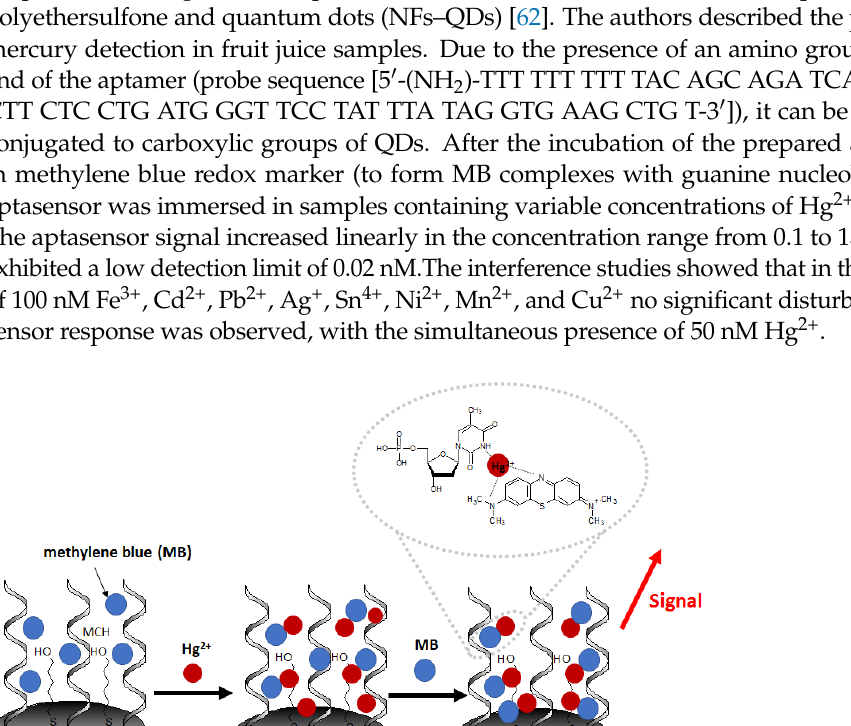
Figure 9. Schematic illustration of signal- on switch aptasensor using “Au nanoflowers” -decorated electrode. Adapted with permission from Zhang et al. [63] (Copyright © (2018) ACS.